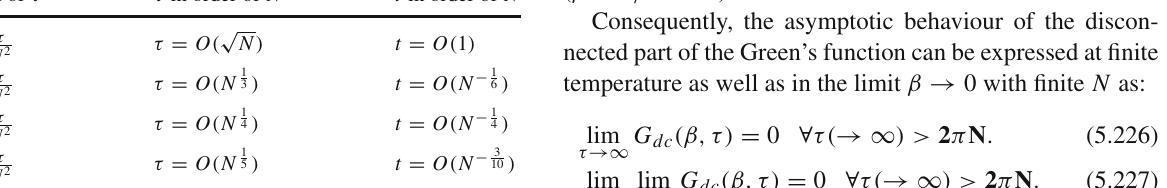
Table4 Orderofmagnitudeestimationofconformaltime( τ )andphys- ical time ( t ) in terms of the order of polynomial N Equation of τ τ in order of N t in order of